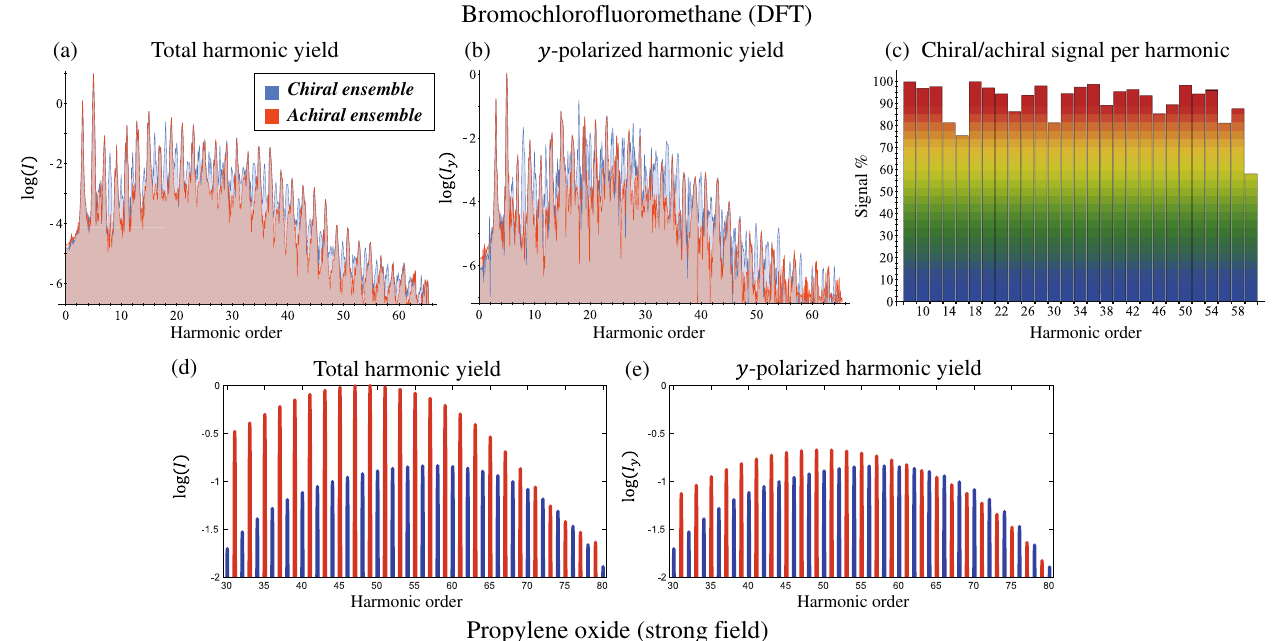
FIG. 5. Dynamical inversion symmetry-breaking-based chirality detection in HHG from DFT-based calculations for CBrClFH [(a) – (c)] and a molecular strong-field model for C 3 H 6 O [(d,e)]. (a) Total orientation-averaged high harmonic signal from the chiral and achiral ensembles of CBrClFH from a DFT-based model for fundamental wavelength λ ¼ 3300 nm, frequency ratios 3 ω − 5 ω in the 1 . 2 × 10 13 W = cm 2 , ϕ ¼ π = 2 , Δ ¼ 1 , ε 0 . 4 , ε 0 . 3 , α ¼ 20 0 , and a trapezoidal envelope with four-cycle turn- pump field, I 1 ¼ 3 ¼ max ¼ on/off and three-cycle flattop. (b) Same as panel (a) but for a y -polarized emitted harmonic signal. (c) Chiral/achiral signal per harmonic order defined through the harmonic integrated y -polarized signal, reaching as high as 99%. (d,e) Orientation-averaged harmonic spectra under similar settings to (a) – (c) from a strong-field model for C 3 H 6 O but with ω − 3 ω in the pump field for fundamental wavelength 5 × 10 13 W = cm 2 λ ¼ 1900 nm, and I max ¼